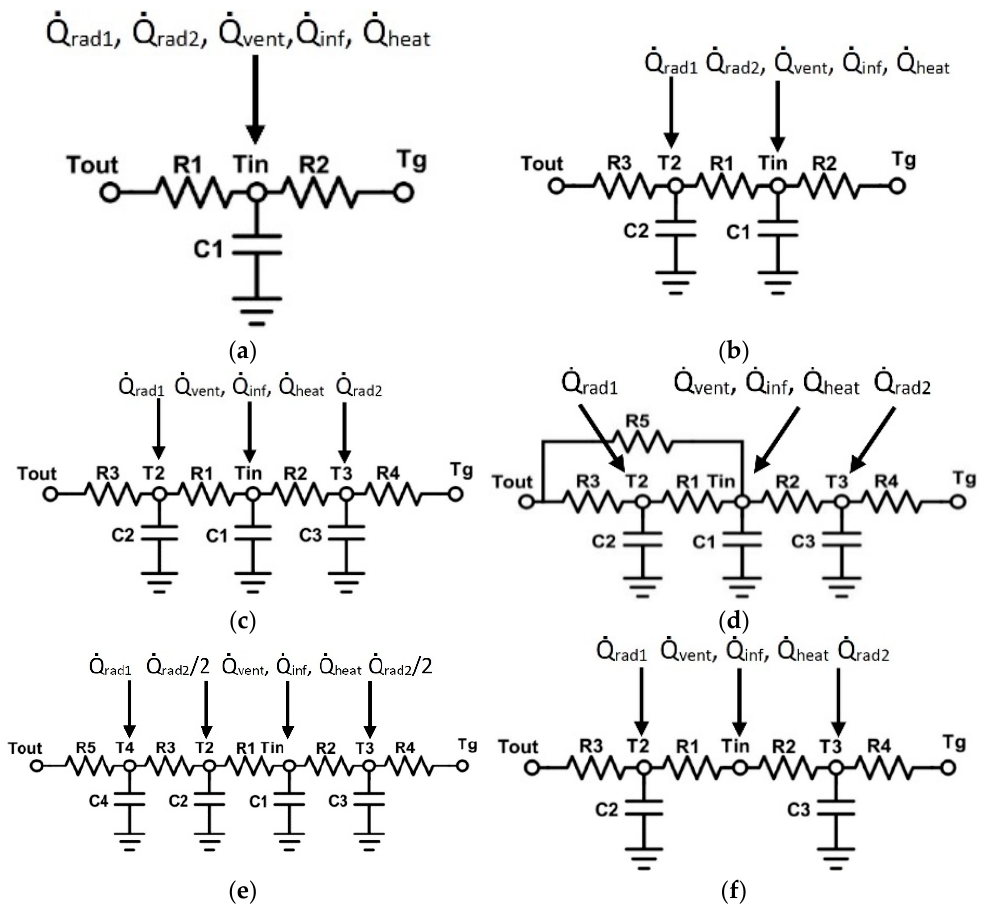
Figure 1. Series of thermal networks for simulating the indoor temperature of a detached building: ( a ) M1: 2R1C; ( b ) M2: 3R1C; ( c ) M3: 4R3C; ( d ) M4: 5R3C; ( e ) M5:5R4C; ( f ) M6: 4R2C.